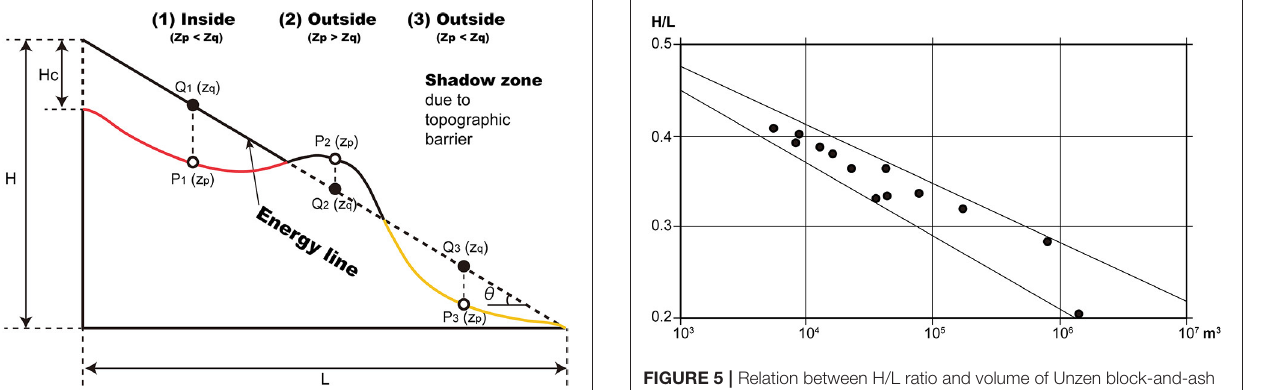
FIGURE 5 | Relation between H/L ratio and volume of Unzen block-and-ash flows, Japan from May 25 to June 8, 1991 (after Takarada et al., 1993). The H/L ratio of 10 4 m 3 PDC is about 0.4. The H/L ratio of 10 6 m 3 PDC is about 0.3–0.2. The larger PDC shows smaller H/L ratio (higher